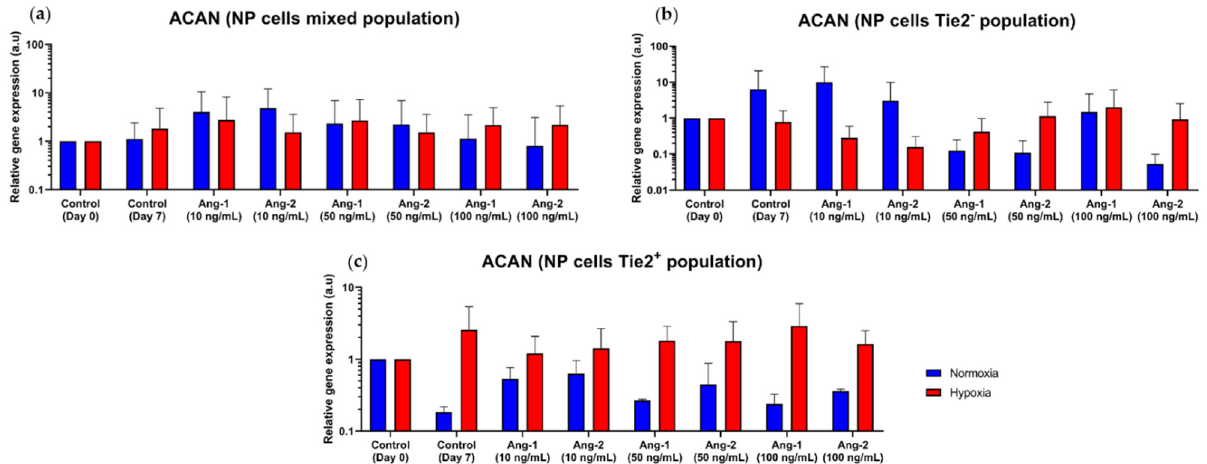
Figure 3. Relative gene expression of the three NP cells populations, comparing the effect of Ang1/2 at different concentrations in normoxia and hypoxia on the ACAN gene expression. The control (Day 0) samples were used as reference (set at 1). Ang-1 and Ang-2 were administrated in three concentrations: 10, 50 and 100 ng/mL. ( a ) ACAN relative gene expression of NP cells mixed population; ( b ) ACAN relative gene expression of NP cells Tie2 − population; ( c ) ACAN relative gene expression of NP cells Tie2 + population. Bars represent mean ± SD.